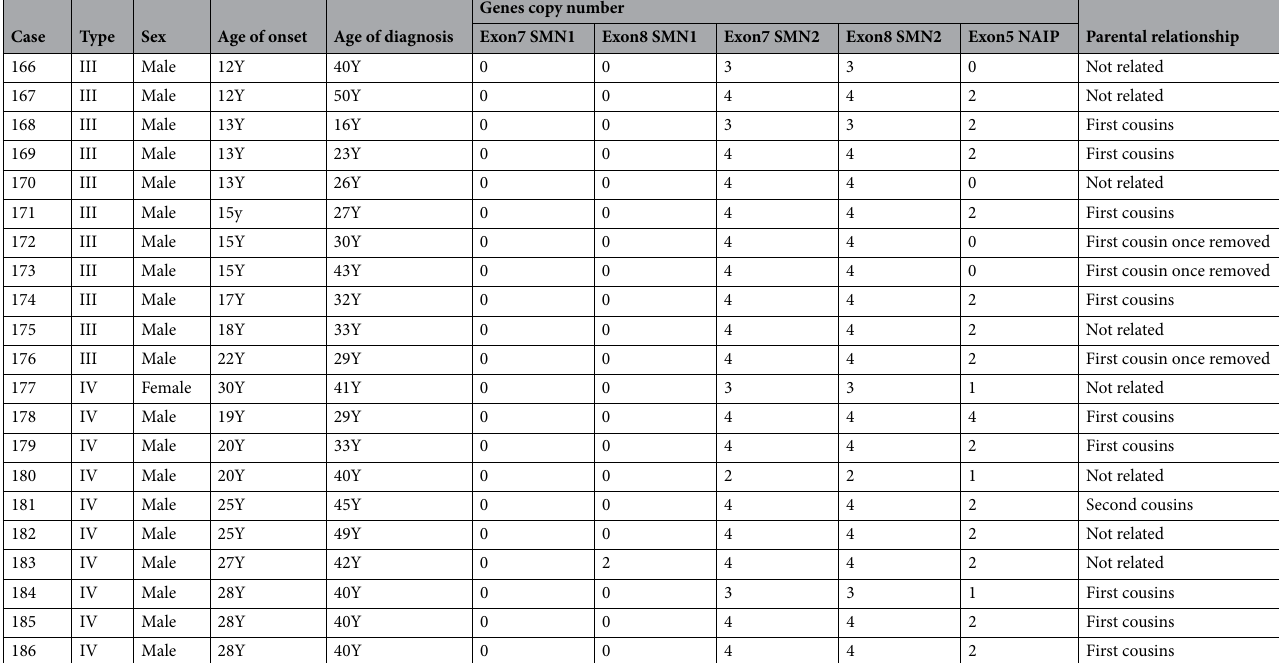
Table 1. Detailed characteristics of patients cohort.